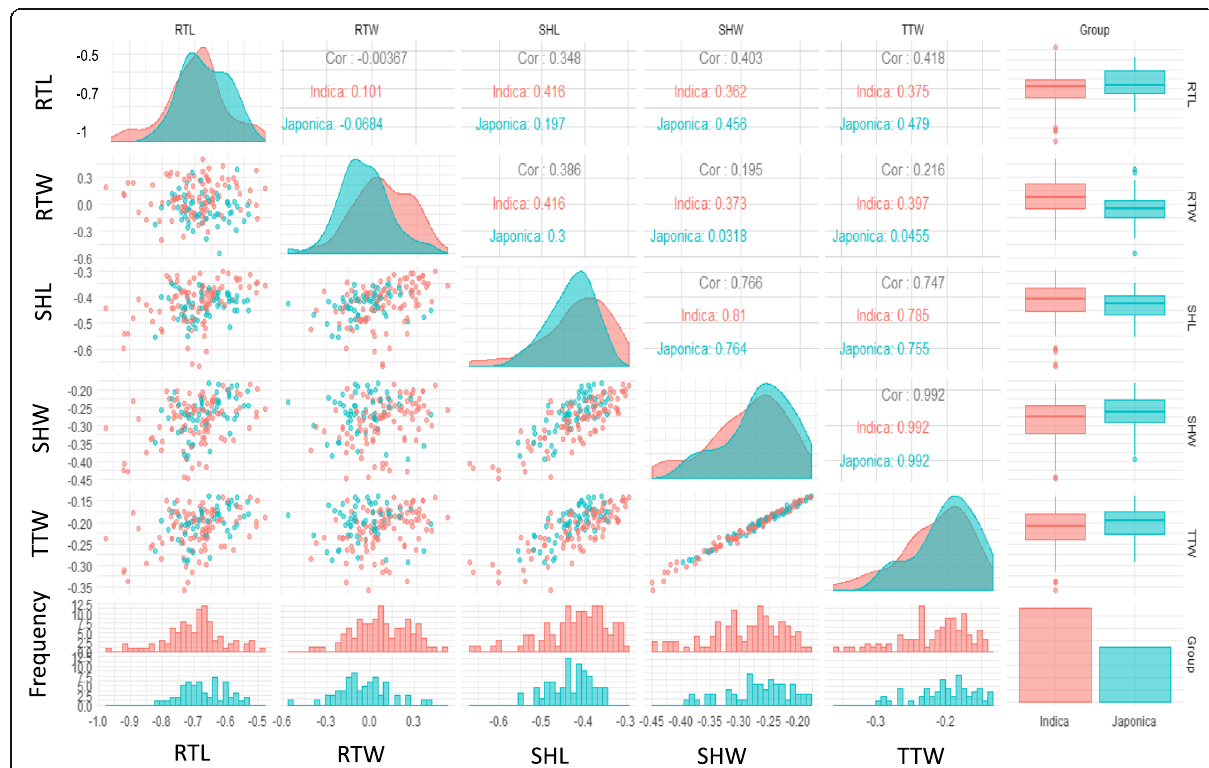
Fig. 3 Phenotypic heterogeneity among Indica and Japonica sub-groups and pair correlation of 5 traits based on the effect of JA. Indica group indicate in pink and Japonica group colored as blue cyan. The distribution of value of each trait in each panel was represented by histogram at the bottom of figure and their median values were shown by boxplot in the right hand. The values pair correlation of traits as well as their plots was shown symmetrically in the figure. The figure was created using “ ggpairs ” package in